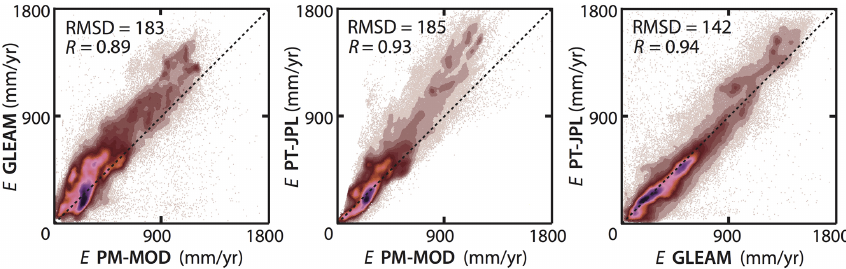
Figure 4. Correspondence in the average spatial patterns for each pair of models. Each point represents a land pixel in Fig. 2. Pearson’s correlation coefficients ( R ) and root mean square differences (RMSDs) are listed.